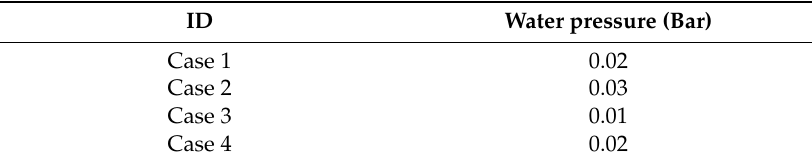
Table 8. Water pressures according to experimental conditions.